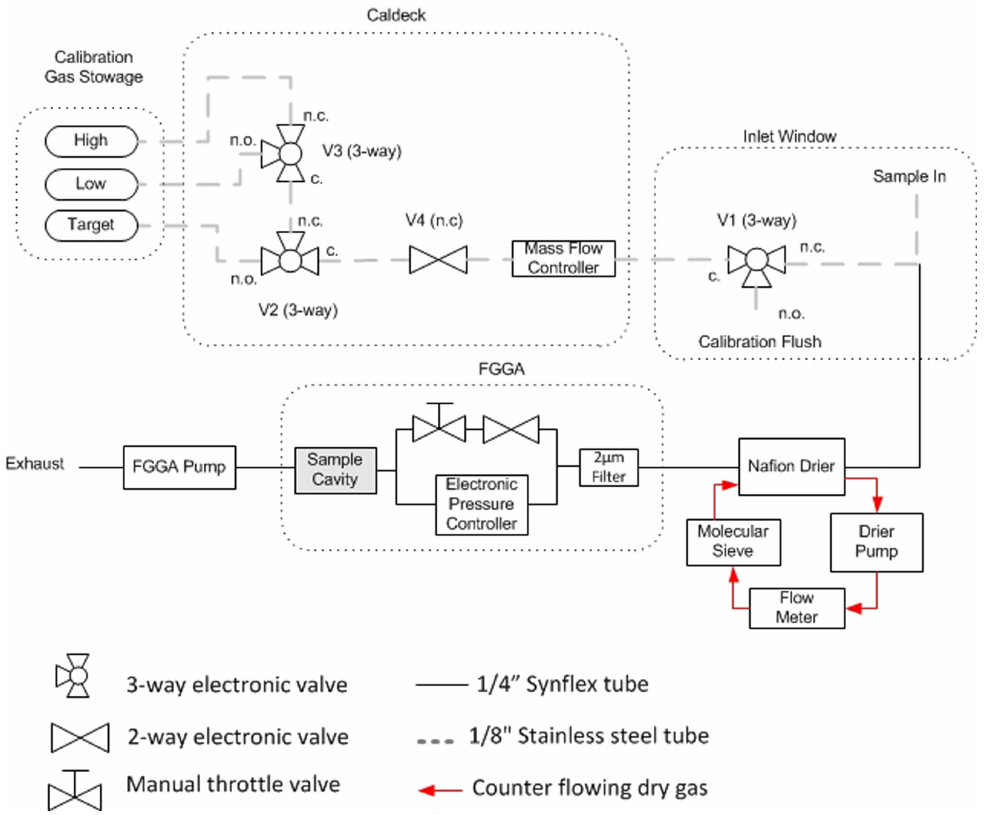
Fig. 1. A diagram of the sample and calibration air flow through the CO 2 and CH 4